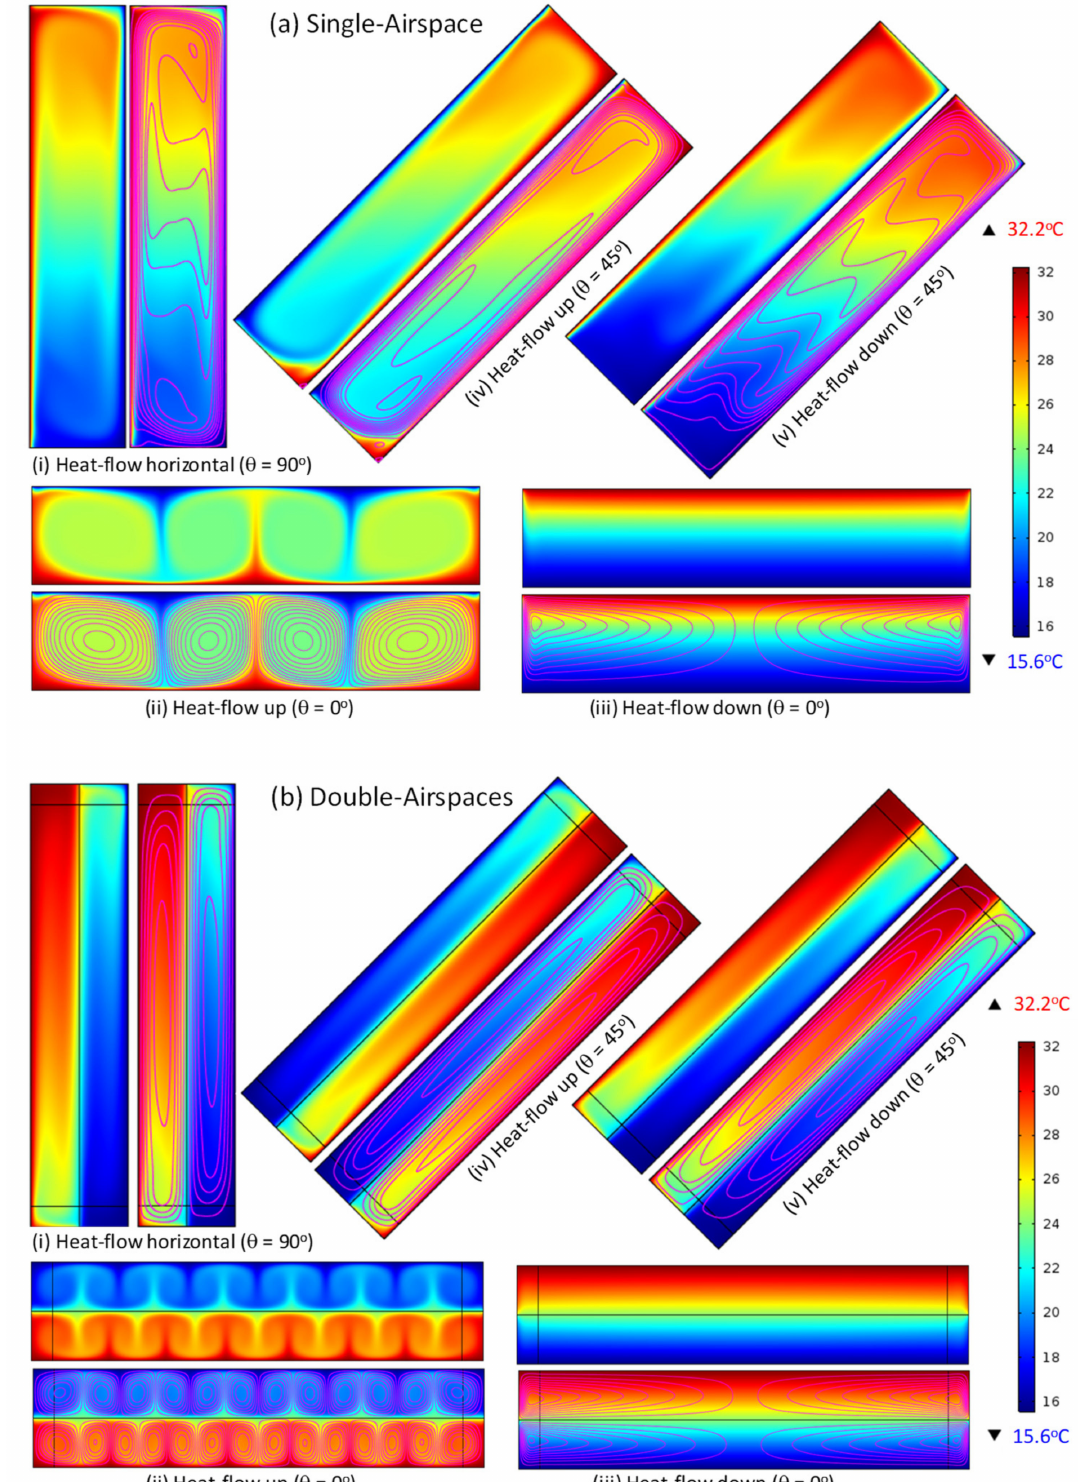
Figure 4. Distributions of temperature and velocity field streamlines in ( a ) a single airspace and ( b ) double airspaces (H = 406 mm (16 inches) and δ = 89 mm (3.5 inches), T H = 32.2 ◦ C (90 ◦ F), T L = 15.6 ◦ C (60 ◦ F), E =